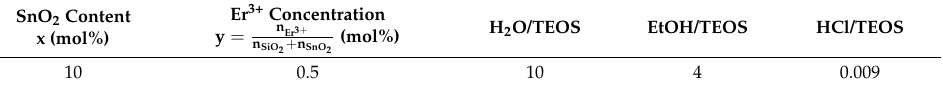
Table 1. Table of the detailed composition of (100 − x)SiO 2 -xSnO 2 :yEr 3+